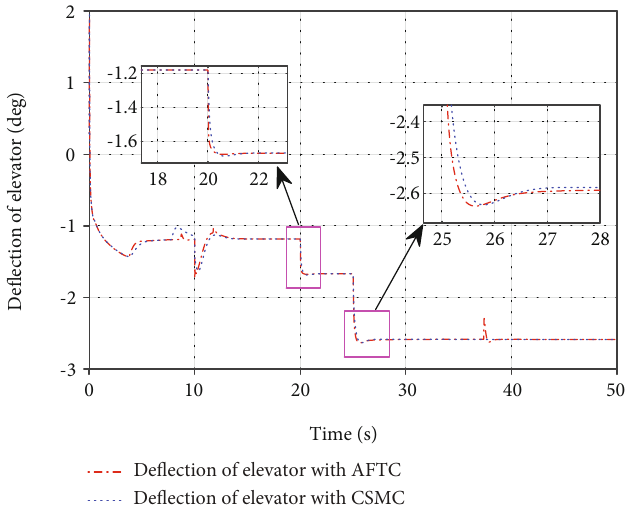
Figure 9: De fl ection of elevator in the presence of concurrent elevator and canard control surface faults in scenario 2.